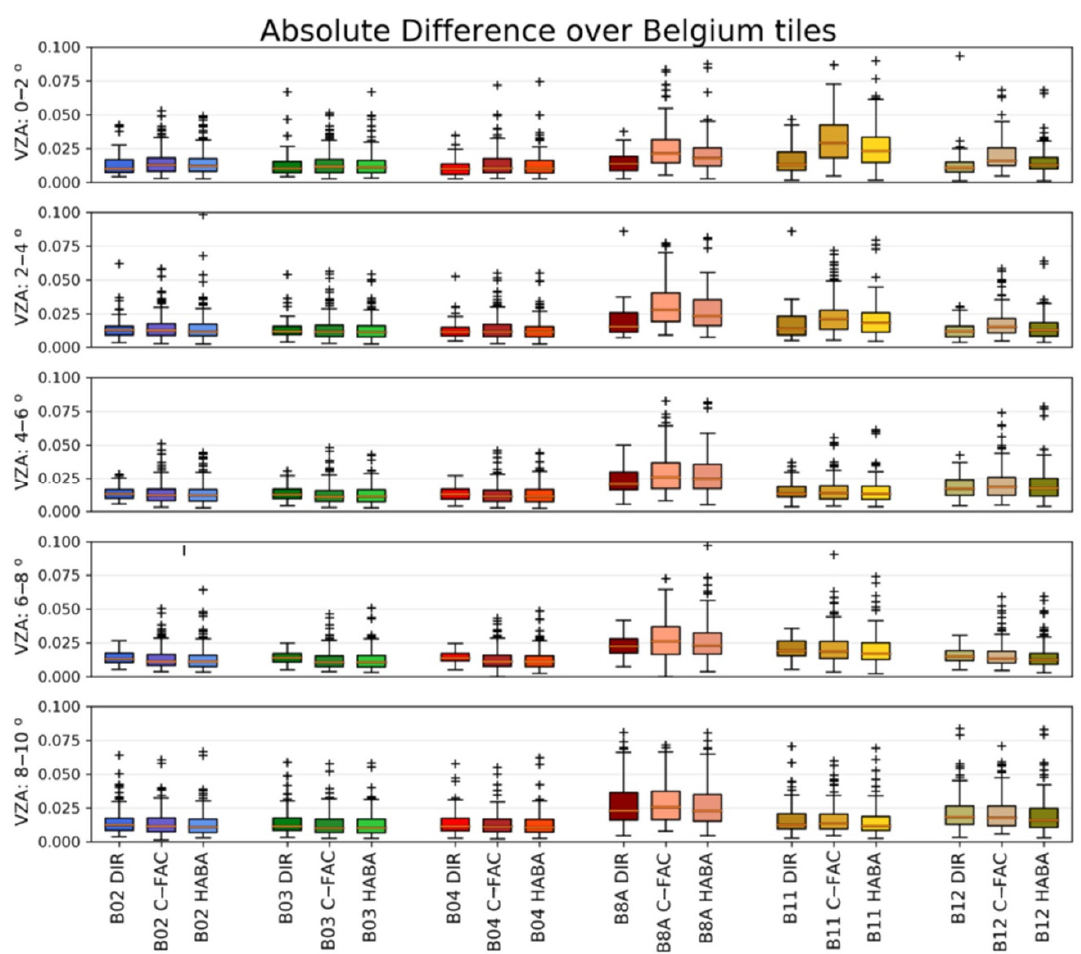
Figure 11. Absolute VZA differences between S2L bands over Belgium MGRS tiles.